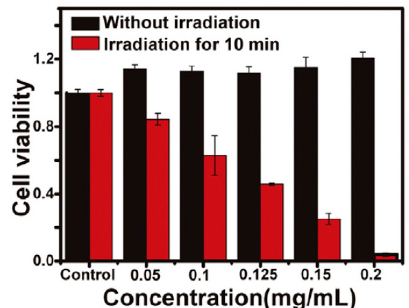
Figure 10. In vitro relative viabilities of A549 cells incubated with nanomaterial based on a tri-malonate derivative of fullerene (C70), with chlorin e6 as a photosensitizer and 1,10-diamino-4,7-dioxadecane (OEG2) as a linker at di ff erent concentrations, with 660 nm (20 mW / cm 2 for 10 min) laser irradiation (red) or in the dark